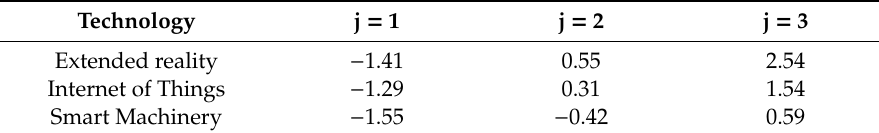
Table 4. α j value of di ff erent technology types for the United